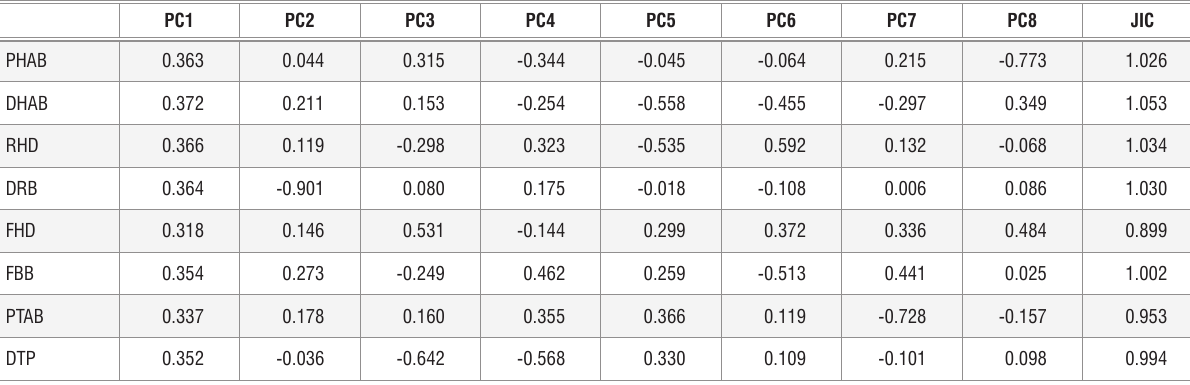
Component loadings for principal components (PC) analysis axes: Gorilla g. gorilla